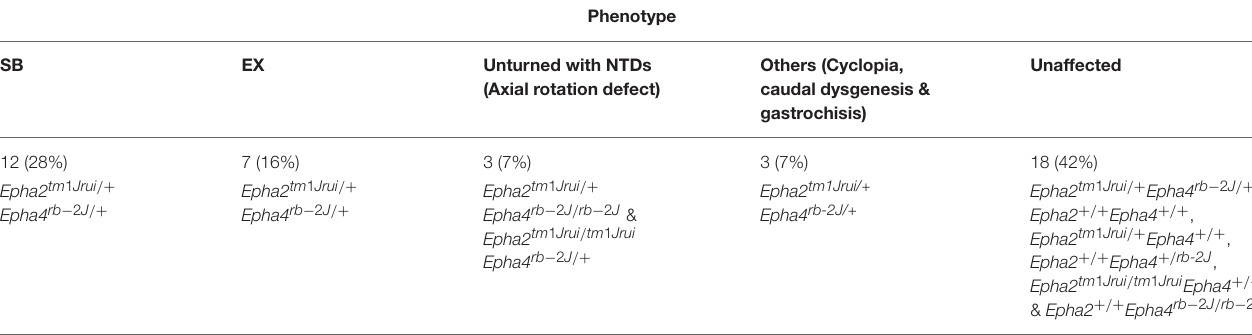
SB, Close Spina bifida (occulta), EX, Close exencephaly, NTDs, Neural Tube Defects.